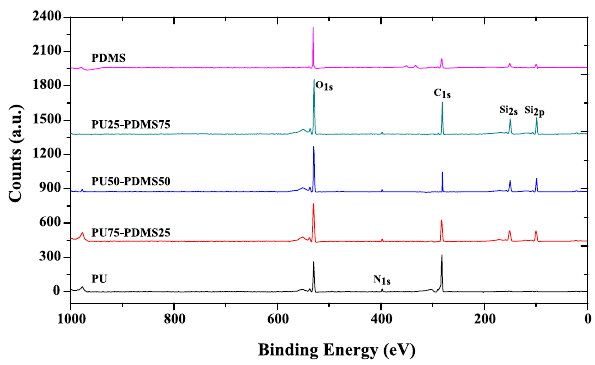
Figure 4: XPS spectrum of PU – PDMS polymer